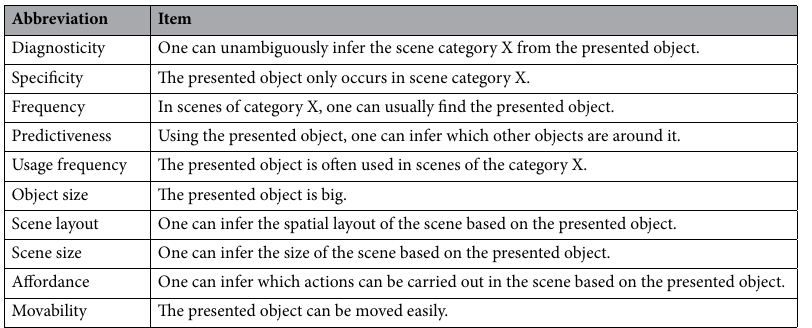
Table 1. Translations of the rating items used in Experiments 2, 3 and 4. The “X” was replaced with the category label of the scene presented on the given trial. Ratings of the diagnosticity item were only collected in Experiment